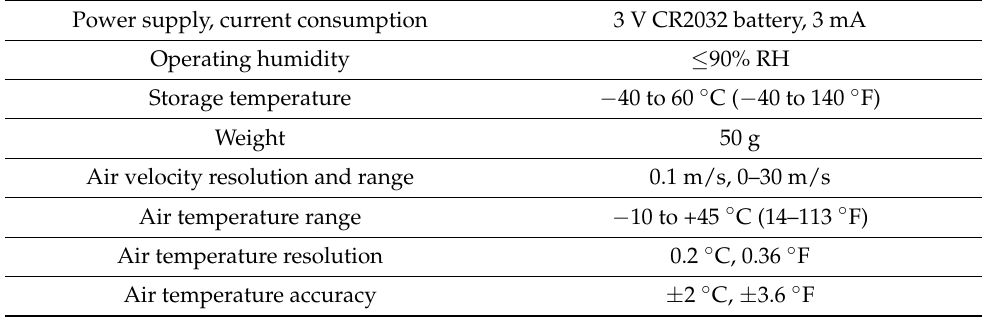
Table 4. Technical data for the